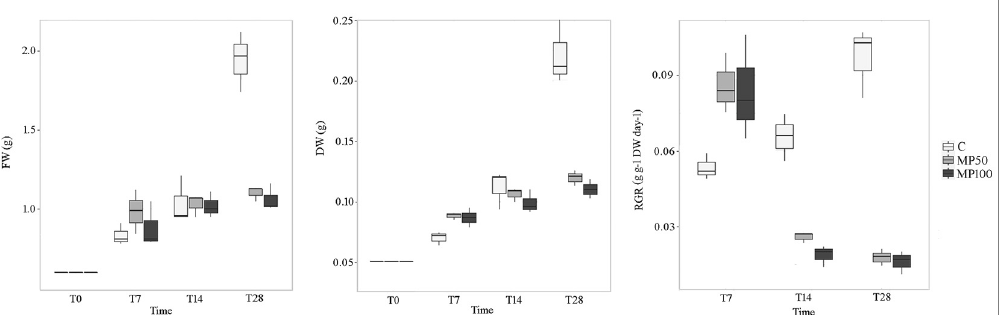
Figure 4 . Fresh weight (FW), dry weight (DW), and relative growth rate (RGR) of L. minuta in control (C) and microplastic treatments (MP50 and MP100) at different exposure times (T0, T7, T14, and T28).